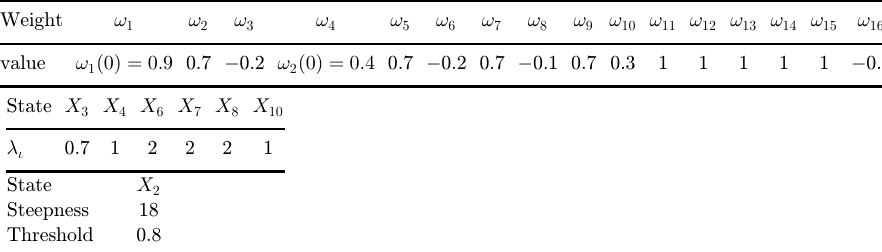
Table 2. Connection weights for the example simulation (Scenario 1).